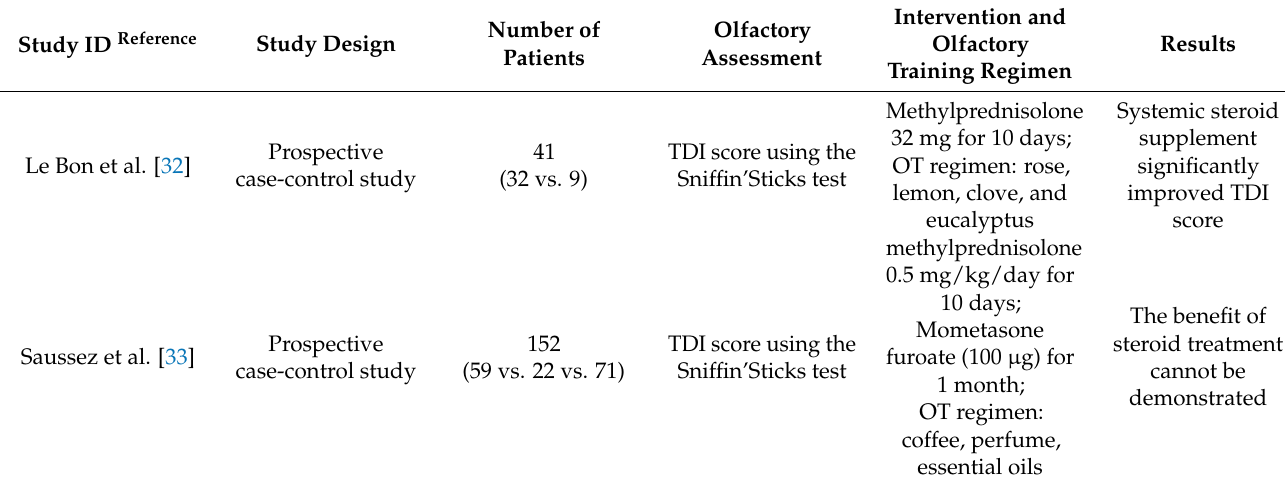
Table 3. Assessment of olfactory improvement according to additional systemic steroid application with olfactory training. TDI, threshold discrimination identification; OT, olfactory